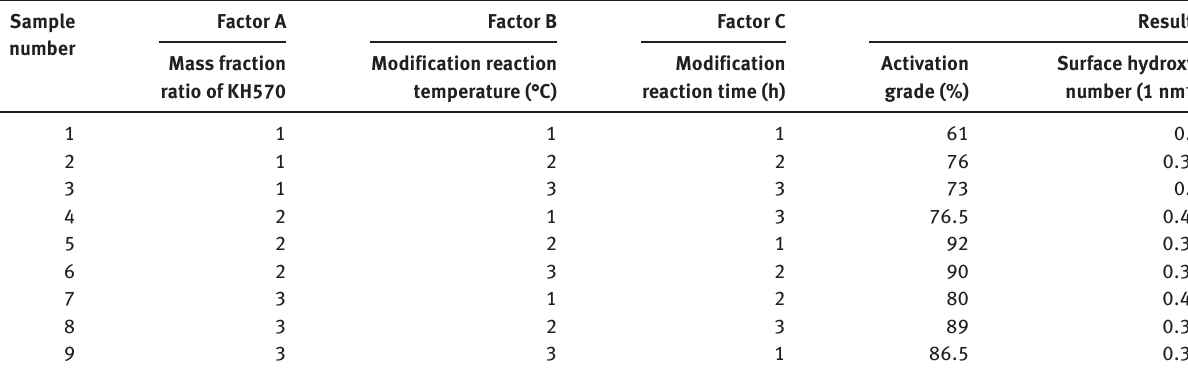
Table 4 Orthogonal test design and test